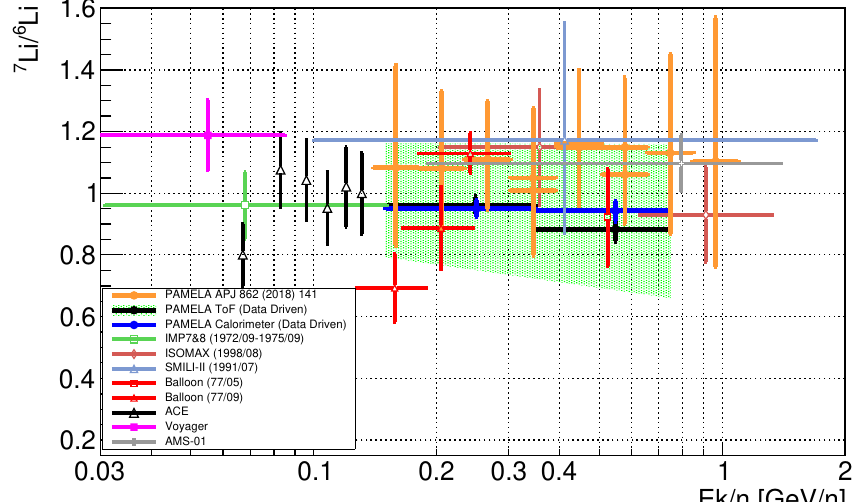
Figure 6. Results of the data-driven measurement of the 7 Li/ 6 Li ratio compared with previous experimental results and with a Monte Carlo based analysis of PAMELA [9] (orange dots). The green shaded contour is the systematic uncertainty inferred for the data-driven